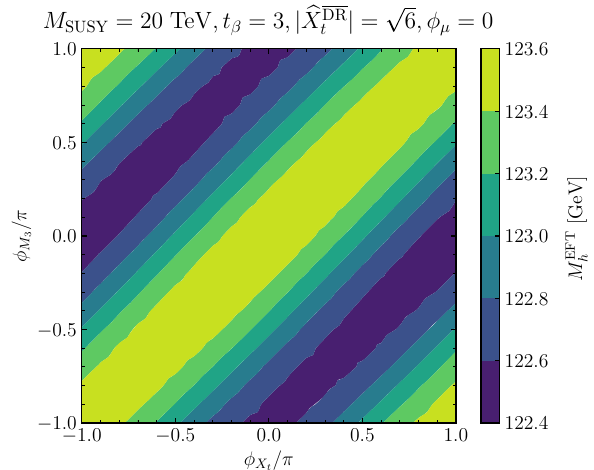
Fig. 7 Result of the EFT calculation using the full phase dependence. The same scenario as in the right plot of Fig. 6 is used, but φ X are varied independently